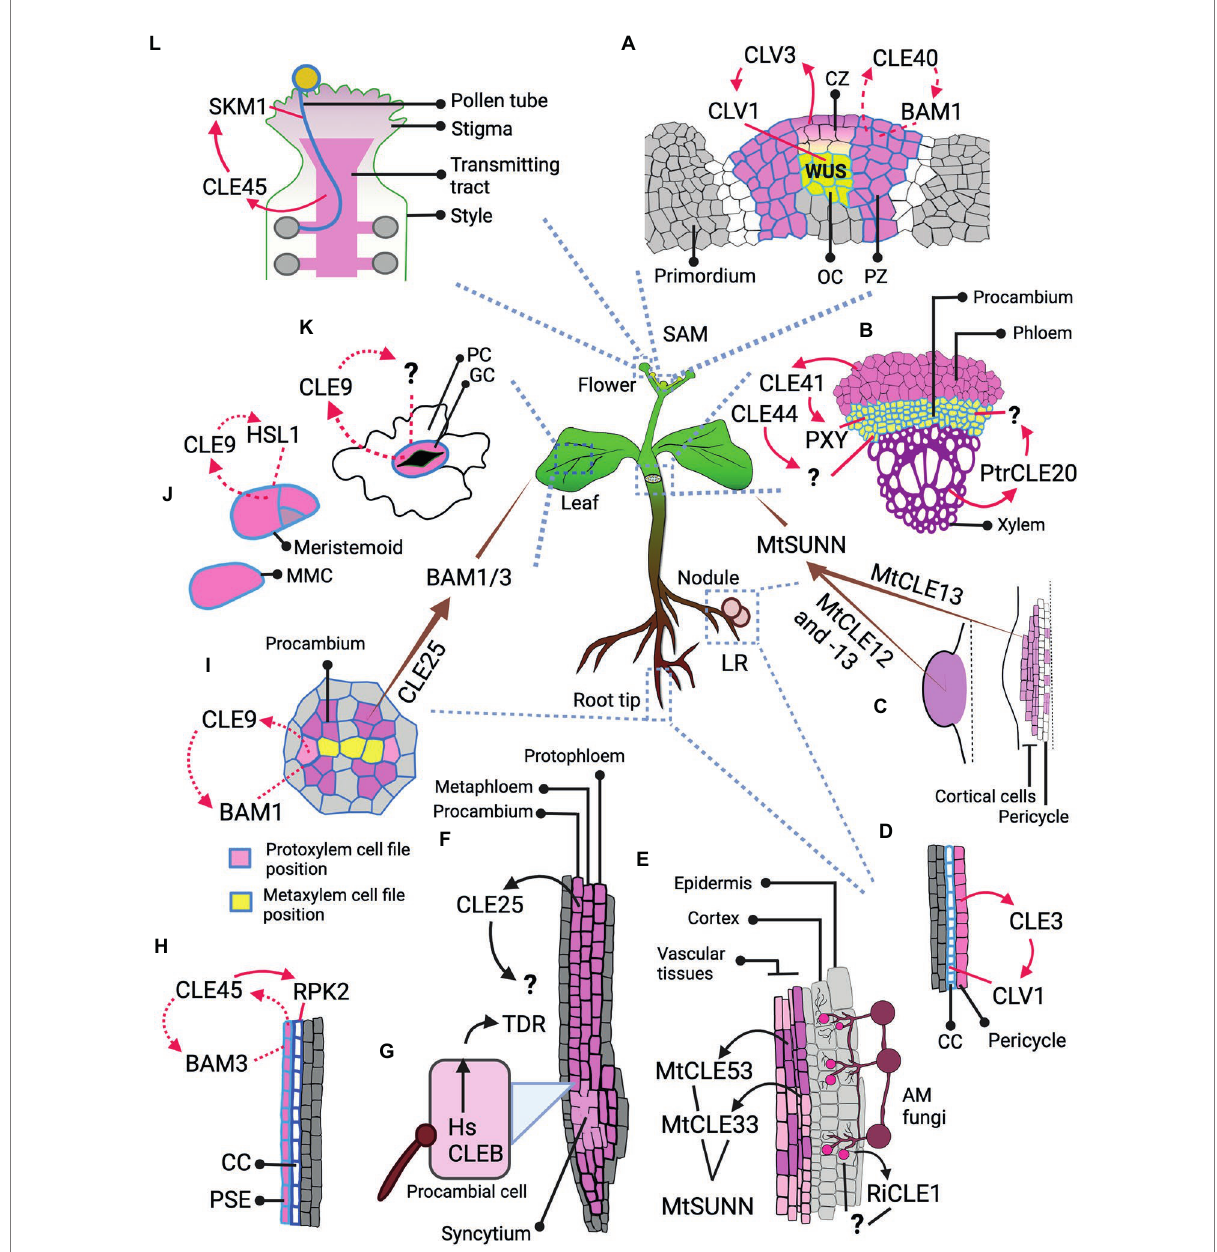
FIGURE 2 Spatial dimension of CLE signaling. The figure illustrates the cell or tissue of origin of the CLE peptide and its destination, and the RLK it binds to at the destination, thus defining whether the signaling type is autocrine, paracrine or endocrine. (A) Signaling in IFM: CLV3, as a paracrine signal from CZ, signals through CLV1 at the OC; CLE40, likely as an autocrine signal, signals through BAM1 at the PZ. (B) Paracrine signaling in vascular development: Arabidopsis CLE41 and CLE44 move from phloem to signal in procambium. CLE41 signals through PXY but the RLK through which CLE44 signals is unknown. In Populus , PtrCLE20 from xylem signals through an unknown RLK in procambium. (C) AON signaling from nodules: MtCLE13 from the cortical and pericycle cells of the developing nodule primordium (on the right), and both MtCLE12, -13 from young, round nodule (on the left) likely act as an endocrine signal and signal through MtSUNN in the shoot. (D) Signaling in LR: CLE3 from pericycle likely acts as a paracrine signal and moves to phloem CC to signal through CLV1. (E) Signaling during AM fungal symbiosis: Rhizophagus irregularis secretes RiCLE1 likely into the epidermal and cortical layers of the Medicago root, but the RLK that receives the CLE signal is unknown. MtCLE53 and - 33 are expressed in the vascular tissues, while MtCLE53 is upregulated close to the fungal infection sites. These CLEs signal through MtSUNN the localization of which is unknown. (F,H) Signaling during root protophloem development: (F) CLE25 is expressed in SPC lineage—protophloem, metaphloem, and procambium, but where and through which RLK it signals remains unknown. (H) CLE45, expressed in PSE, mediates an autocrine signaling regulation through BAM3 and likely a paracrine signaling regulation in CC through RPK2. (G) Signaling by nematode: HsCLEB, secreted by nematodes into the procambial cells, signals through TDR but it is not clear where it is expressed. (I) Autocrine signal in vascular development: CLE9, expressed in xylem precursors, signals through BAM1 expressed in vascular cells including xylem precursors. (I–K) Signaling in leaf: (I) CLE25, expressed in vascular procambium of root, acts as an endocrine signal and signals through BAM1/3 expressed in leaves for stomatal